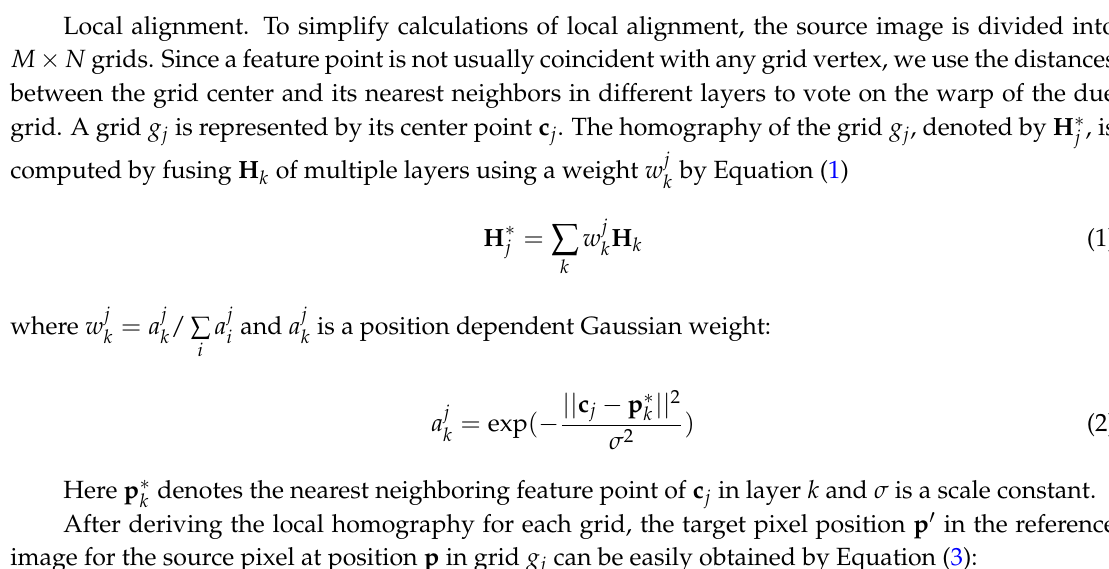
Figure 3. Examples of matched feature points in multiple layers, different color indicate different layers: ( a ) multiple-layer matched feature pairs of images with large parallax; ( b ) multiple-layer matched feature pairs of images with a distant plane and ground